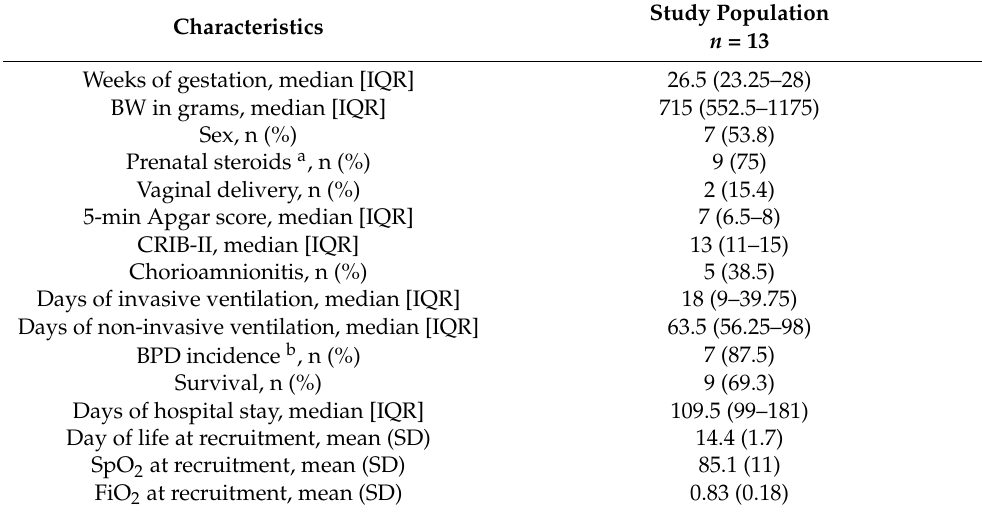
Table 1. Clinical characteristics of the patients enrolled. Characteristics